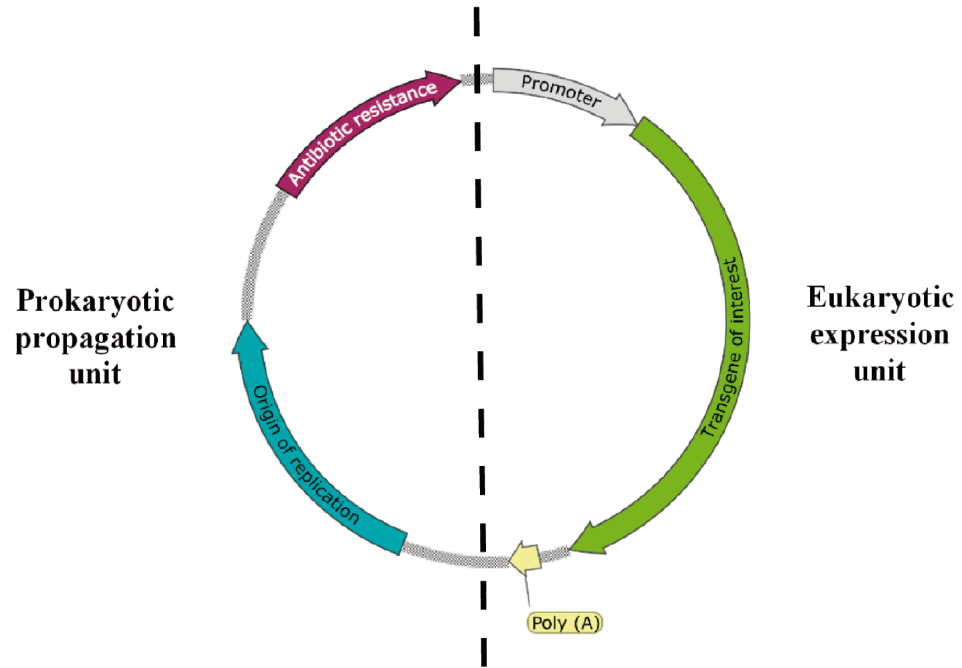
Figure 2. Essential elements of a plasmid DNA vector. The propagation unit should contain the antibiotic resistance gene and the bacterial origin of replication, for propagation and selection in bacteria. The expression unit should include the gene encoding the protein of interest, under the control of a ubiquitous (e.g., viral) promoter, and with transcription termination sequences (Poly A).